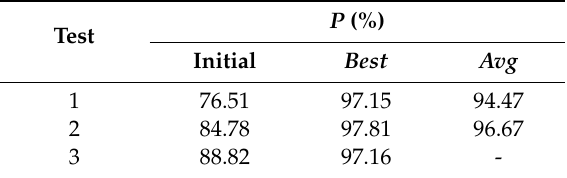
Figure 10. The proportion of the maximum coverage ratio in each numerical interval, in which the distribution proportion of the maximum coverage ratio in the three tests is shown, including 20 rounds of Tests 1 and 2, respectively, and a round of Test 3. Table 1. The simulation results of the best and avg coverage ratio of Tests